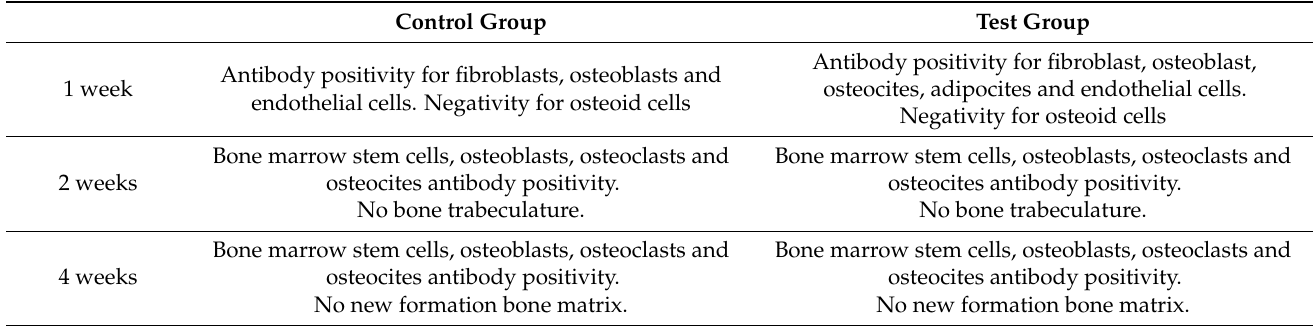
Table 3. TNF- α expression on both groups evaluated by the immunohistochemical tests. Control Group Test Group Antibody positivity for fibroblast, osteoblast, Antibody positivity for fibroblasts, osteoblasts and osteocites, adipocites and endothelial cells. endothelial cells. Negativity for osteoid cells Negativity for osteoid cells